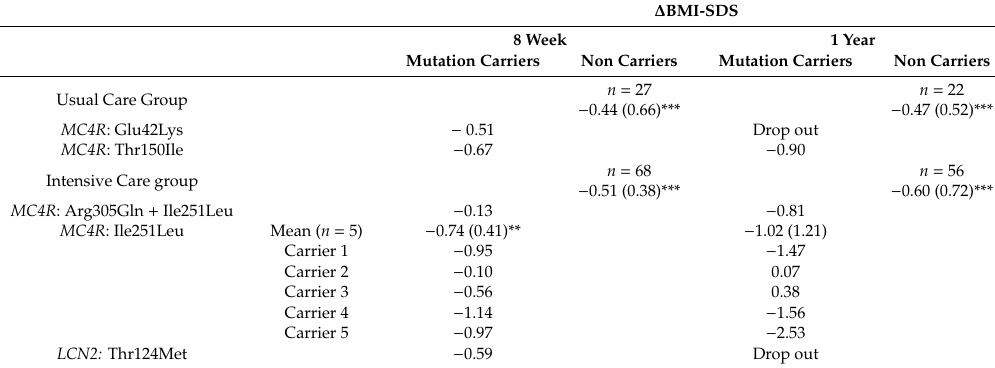
Table 3. Changes in BMI-SDS according to MC4R and LCN2 variants after an 8-week and 1-year lifestyle intervention.